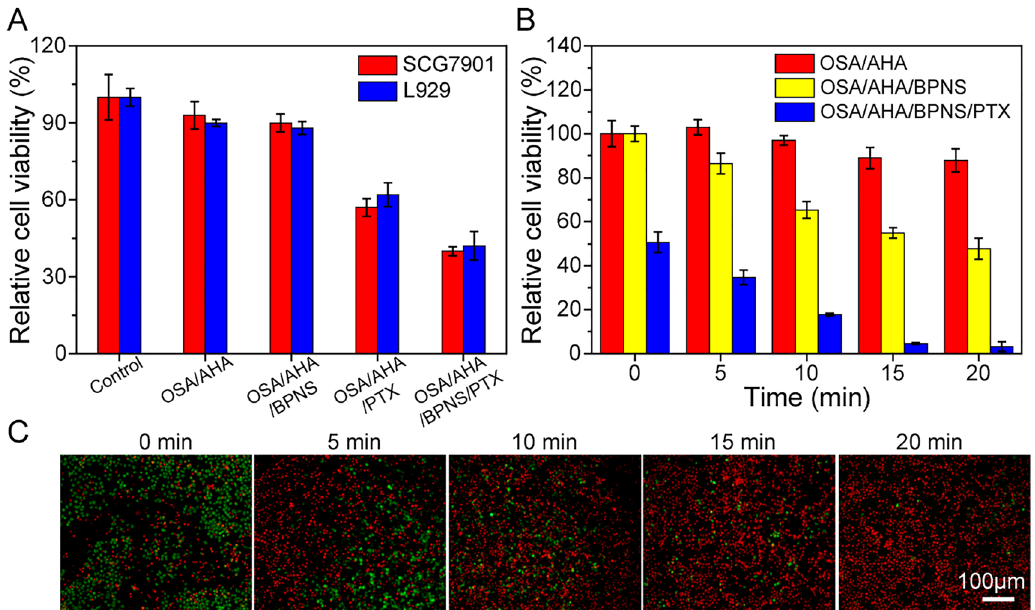
Figure 4: (A) The effect of different experimental groups on cell viability of SGC7901 and L929. (B) Relative cell viabilities of SGC7901 cells treatedwithdifferentlaserirradiationtimes.(C)Fluorescentimagesofacridineorange(green,livecells)andpropidiumiodide(red,deadcells) contained SGC7901 cells after addition of OSA/AHA/BPNS/PTX and exposure to laser irradiation for 0, 5, 10, and 20